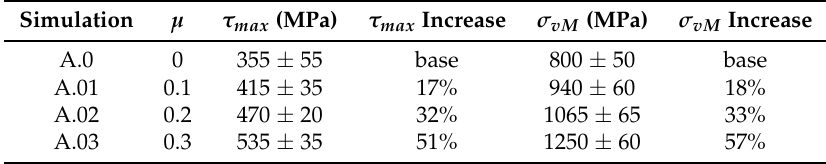
Figure 8. Evolution of process descriptors along the different steps of the simulation for different coefficients of friction. Top . Contact area between the ball and surface material. Bottom . Burnishing pressure. Table 8. Estimation of local von Mises and maximum shear stress for simulations with different coefficients of